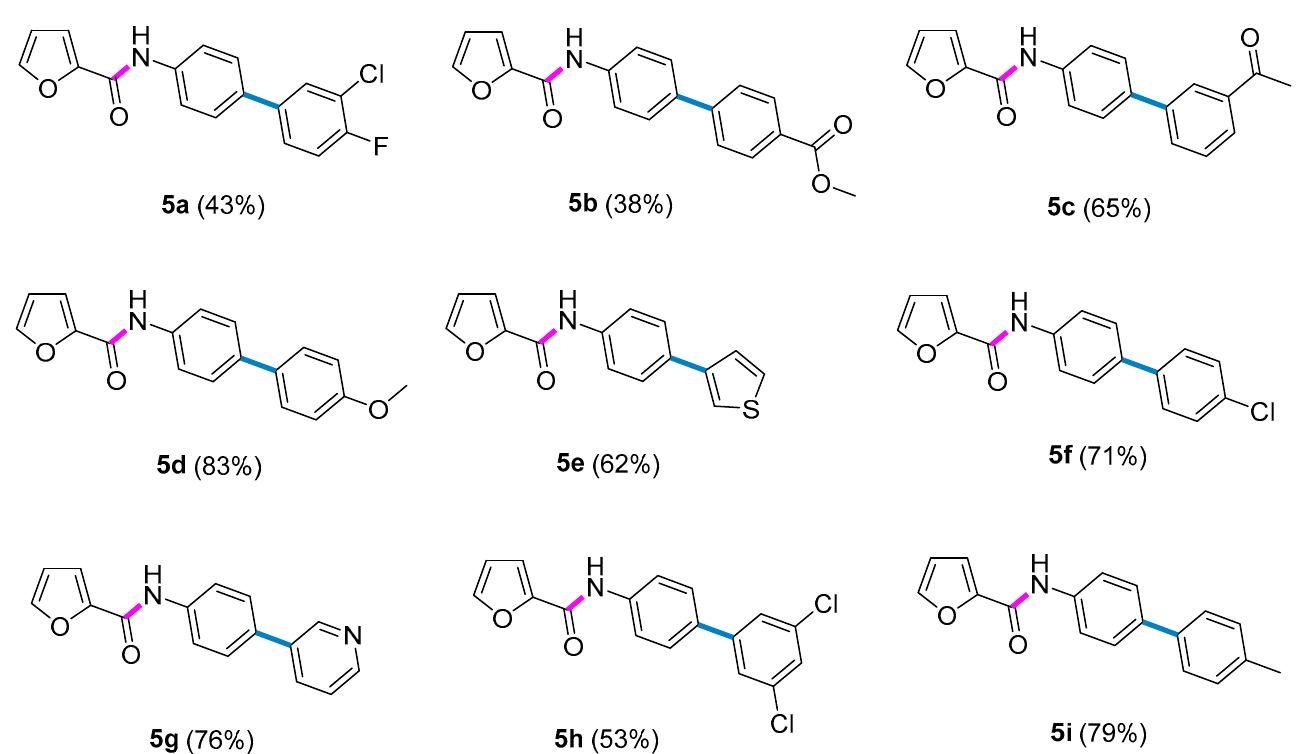
Figure 1. An overview of N -(4-aryl phenyl)furan-2-carboxamide ( 5a-i ) via Suzuki–Miyamura cross-coupling reactions.